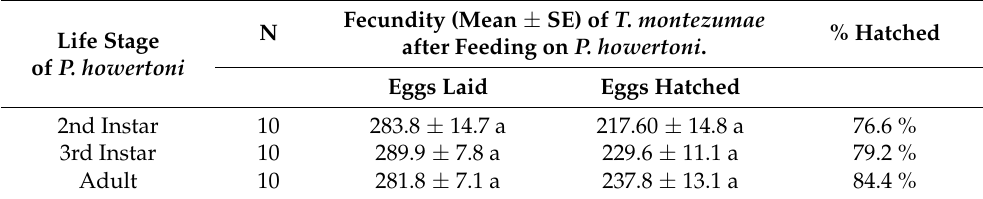
Table 3. Percentage egg hatch for T. montezumae fed different life stages of P. howertoni . Fecundity (Mean ± SE) of T. montezumae % Hatched N Life Stage after Feeding on P. howertoni . of P. howertoni Eggs Laid Eggs Hatched 2nd Instar 10 283.8 ± 14.7 a 217.60 ± 14.8 a 76.6 % 3rd Instar 10 289.9 ± 7.8 a 229.6 ± 11.1 a 79.2 % Adult 10 281.8 ± 7.1 a 237.8 ± 13.1 a 84.4